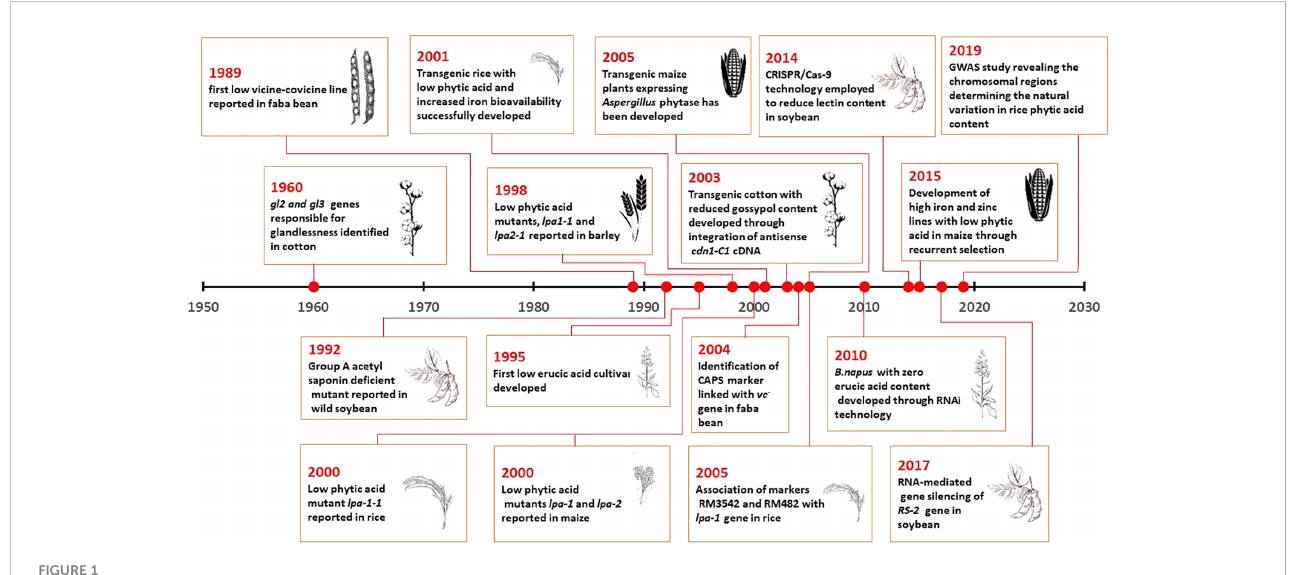
FIGURE 1 Timeline of Anti-nutritional Breeding in major